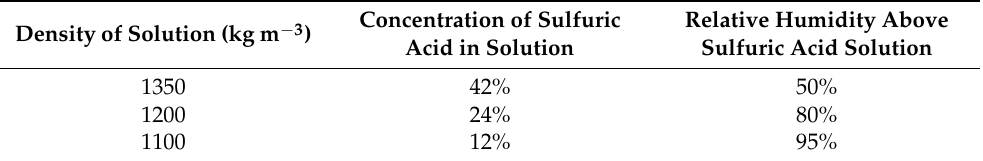
Table 2. Mixing ratio for sulfuric acid and demineralized water.